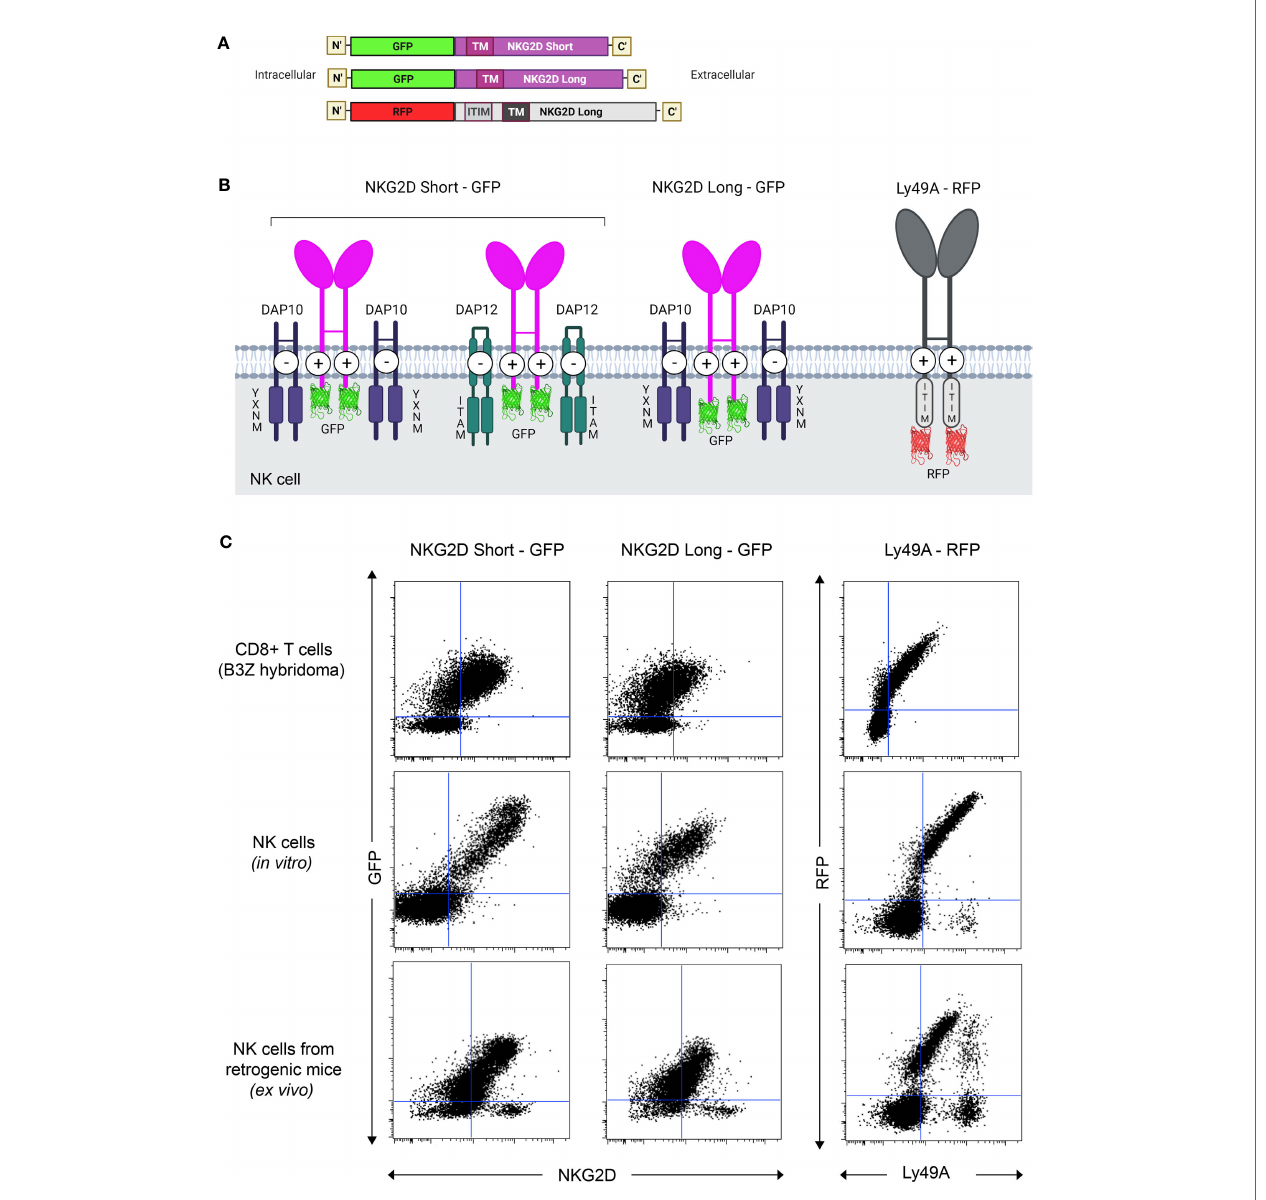
FIGURE 1 | Generation and expression of NKG2D(S/L)-GFP and Ly49A-RFP-expressing natural killer (NK) cells in vivo . (A) Schematic representation of the constructs of mouse NKG2D-GFP and Ly49A-RFP used for functional and colocalization studies. All constructs were subcloned into the pMIGR1 retroviral expression vector. (B) Schematic of NKG2D-GFP and Ly49A-RFP at the NK cell surface. Both molecules form homodimers. Image representation is not to scale. (C) NK cells expressing NKG2D-GFP and Ly49A-RFP generated in vivo . Retroviral-mediated expression of NKG2D-GFP (S/L) and Ly49A in murine B3Z CD8+ T cell line (top), NK cells differentiated in vitro from hematopoietic progenitor cells (HPCs, middle) and NK cells obtained from retrogenic (RT) mice (bottom, see also Supplementary Figure S1 ). Experiments with NK cells differentiated in vitro were performed by transducing HPCs from NKG2D-de fi cient C57BL/6 mice ( Supplementary Figure S2 ), and the data shown are gated on NK1.1+, NKp46+, and CD3- cells. Splenic NK cells from RT mice were gated as CD3-, CD8-, NK1.1+, and CD49+ (DX5) cells. The data are representative of more than three